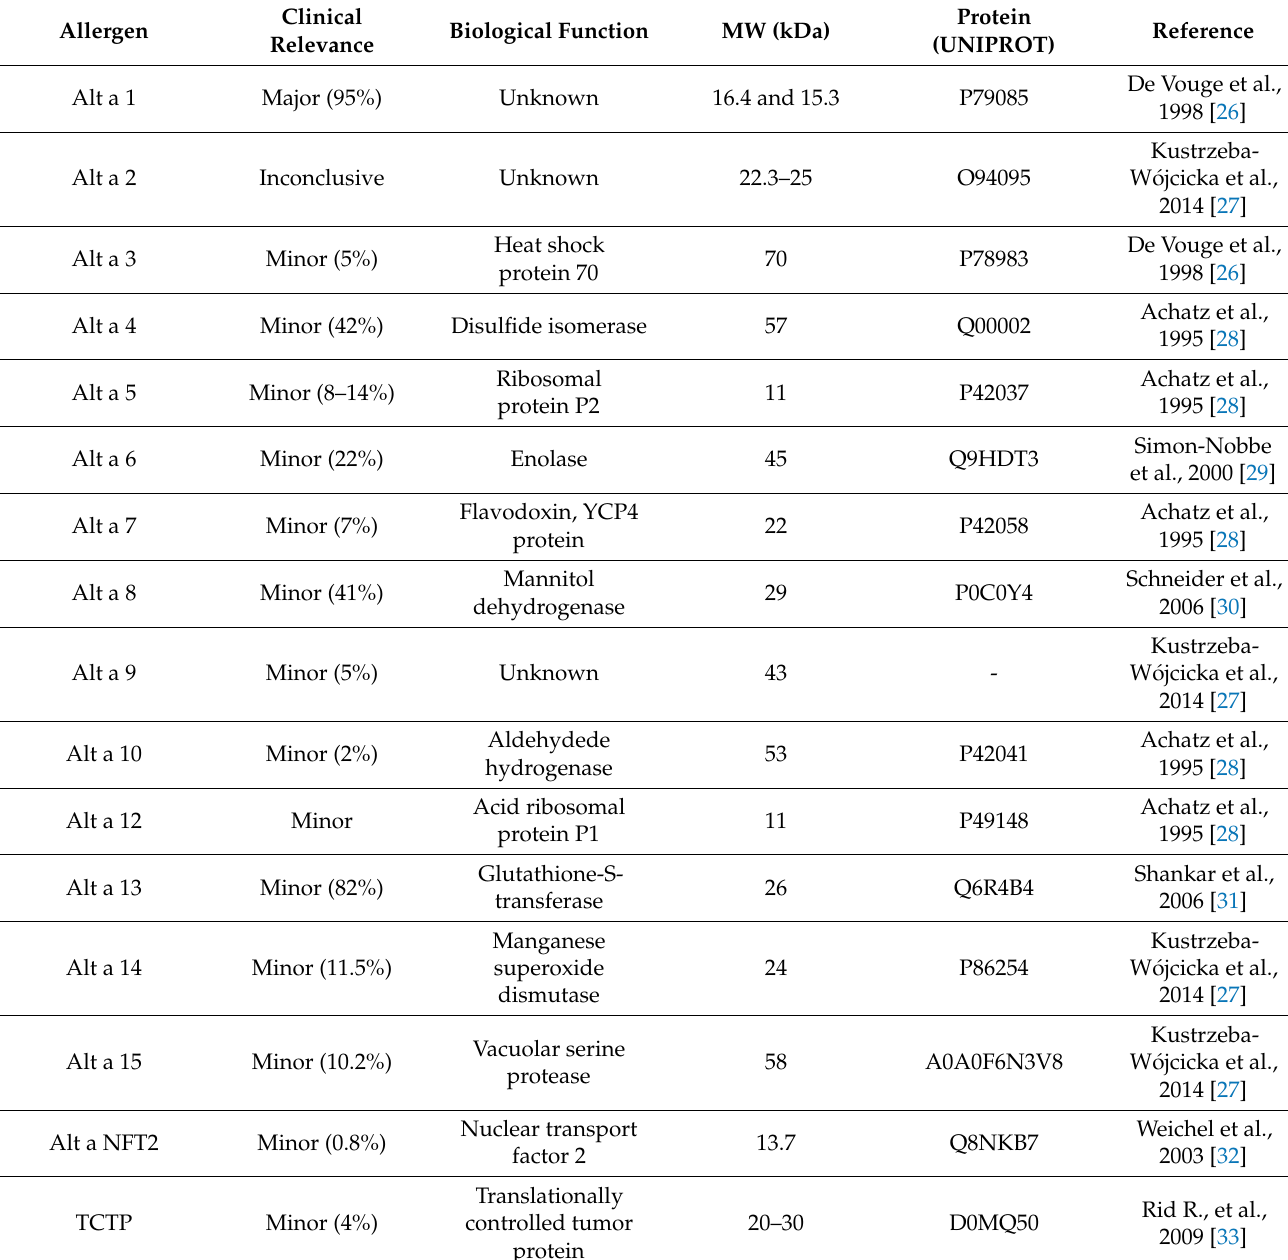
Table 1. Alternaria alternata